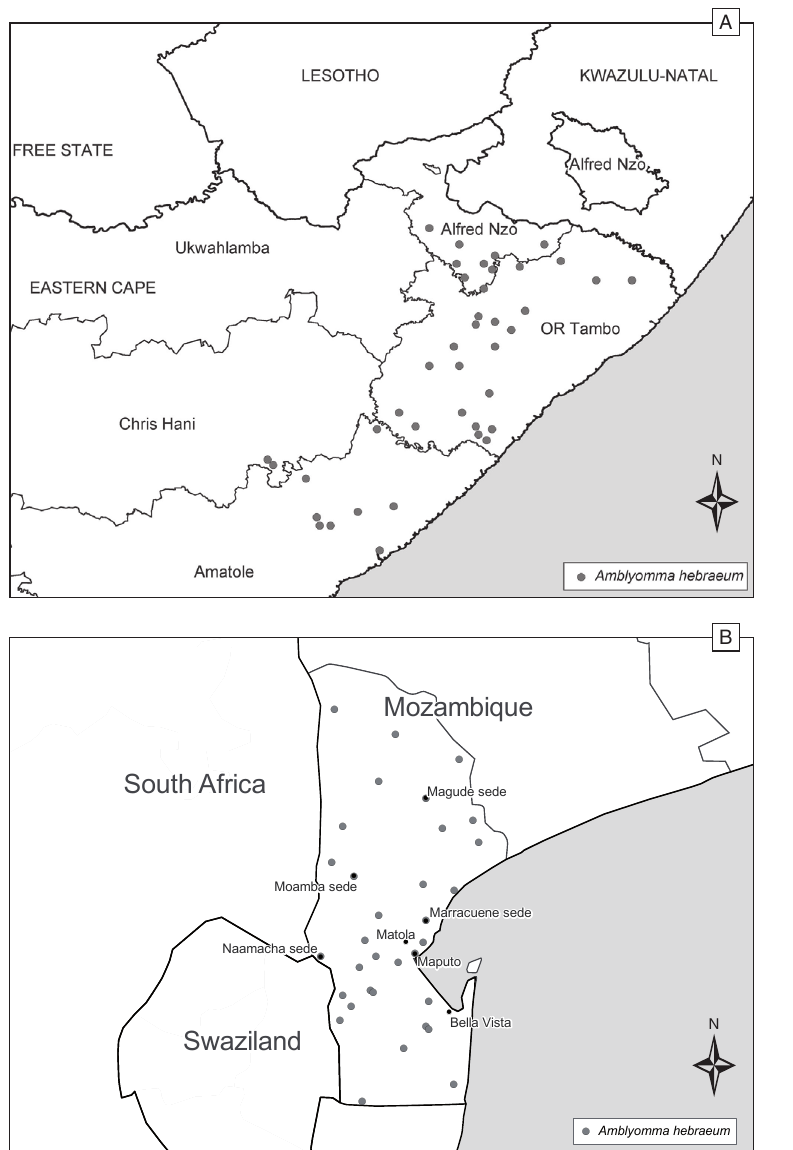
The geographic distribution of Ambly om­ ma hebraeum in (A) the eastern region of the Eastern Cape Province, South Af ri ca, and (B) Maputo Prov ince, Mo zam